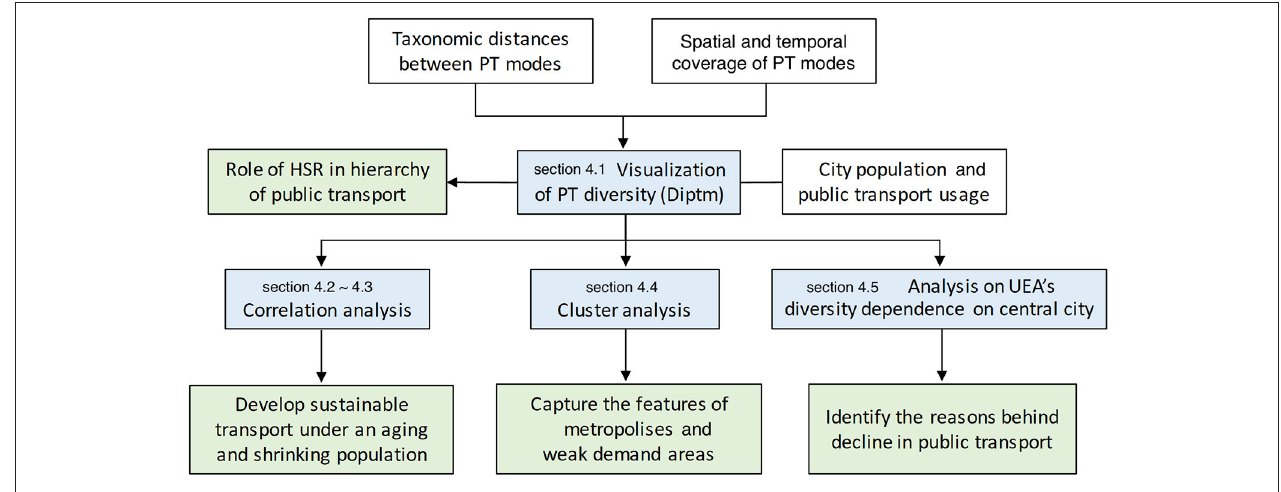
FIGURE 3 | Analytical